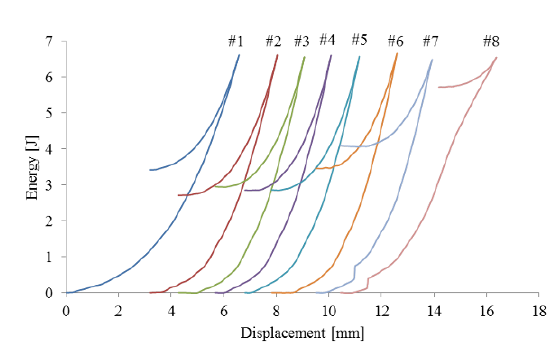
Figure 6. Energy-displacementcurveswithdisplacementoff-setfrom impact #2.